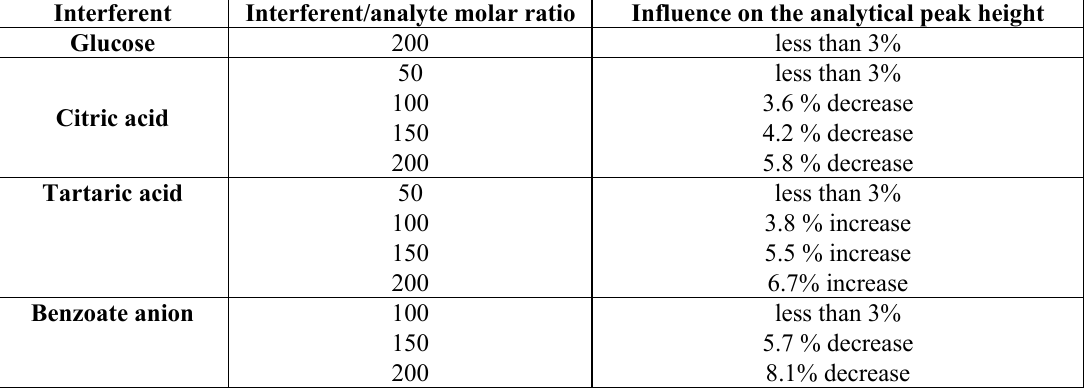
Table 2. Study of interferences at ascorbic acid determination by DPV at a carbon paste electrode, performed on some chemical species commonly found in fruit juices, soft drinks and